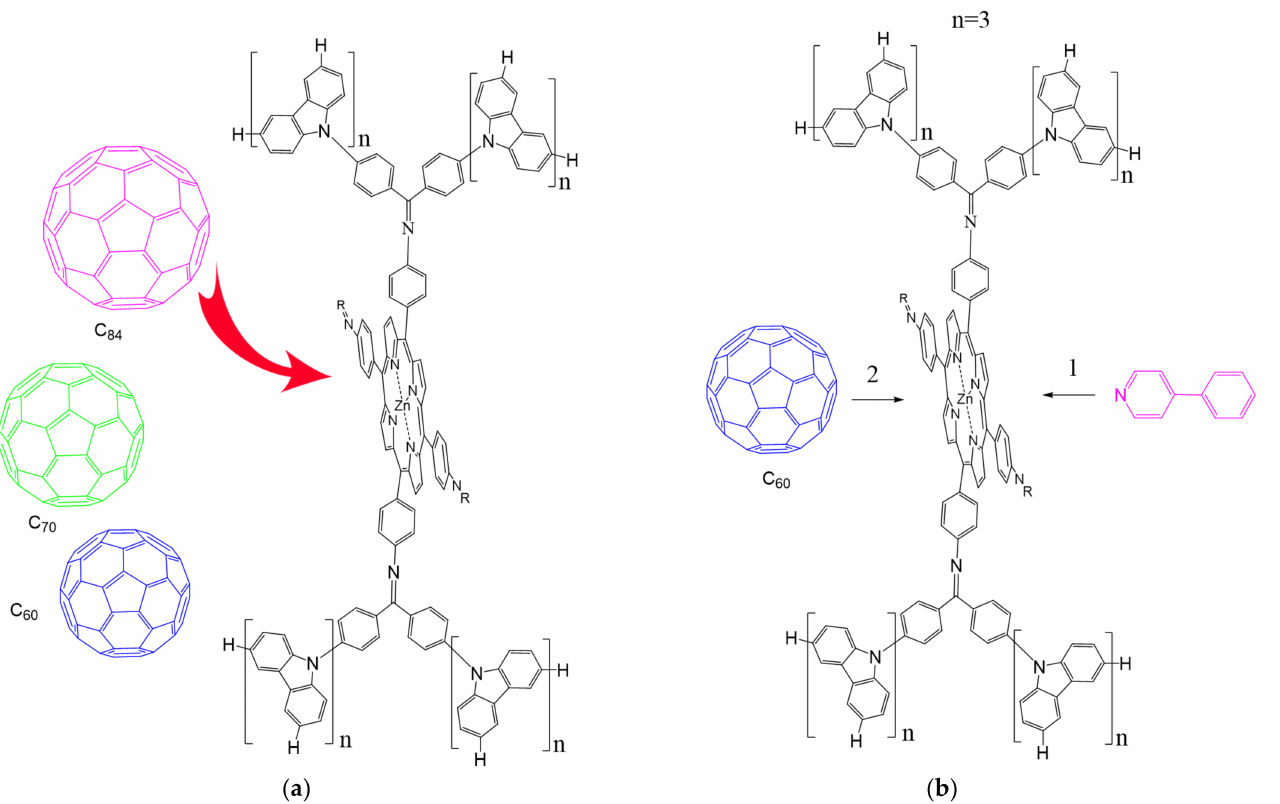
Figure 29. The scheme of selective binding of the fullerenes by 87G 2 in absence ( a ) and presence ( b ) of the